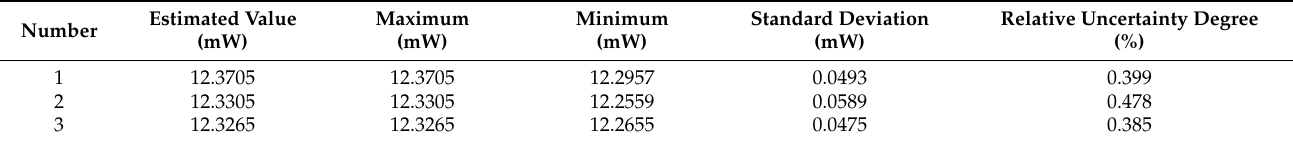
Figure 14. Variation in the total energy received with time during the PD gaze time in Experiment 2. Table 4. The relative uncertainty of the stability of halogen lamp in Experiment 2.